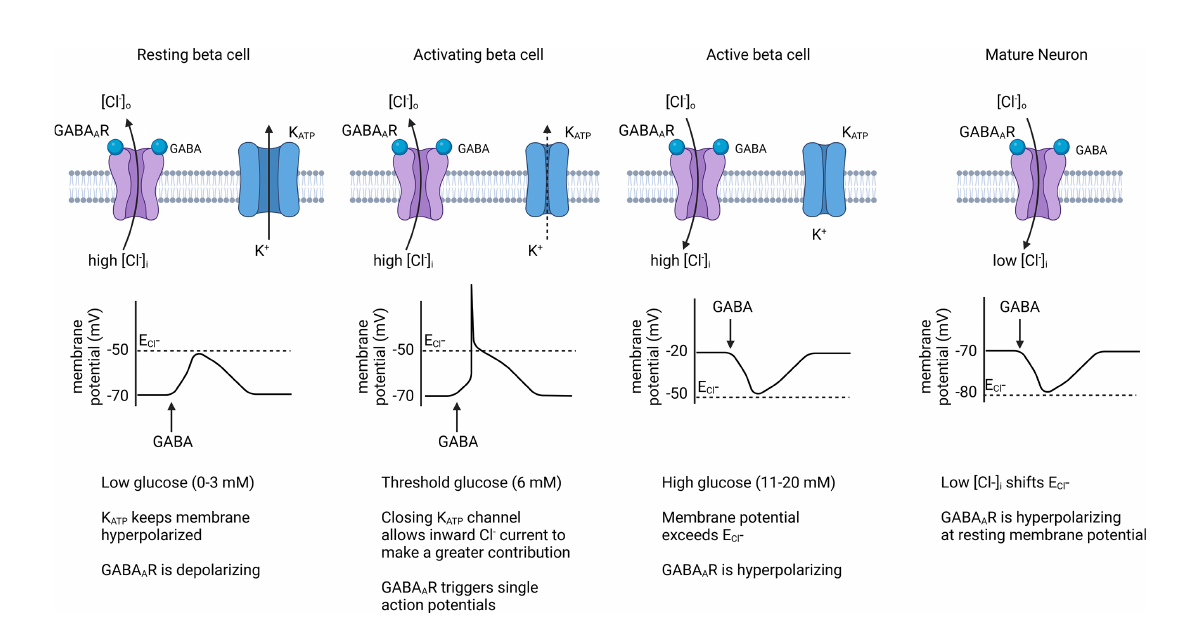
FIGURE 4 Effect of GABA A R chloride channels on beta cell membrane potential. When membrane potential is below the Cl - equilibrium potential (E Cl -), endogenous GABA A R activation contributes to beta cell depolarization and can trigger action potentials in threshold-activated beta cells. Once the beta cell membrane becomes depolarized past E Cl - during an active phase, GABA A R activation results in repolarization of the membrane, causing an inhibitory effect on insulin secretion. Because beta cells have a high [Cl - ]i, its sets the E Cl - at a higher level than for mature neurons where GABA A R is generally inhibitory. Created with